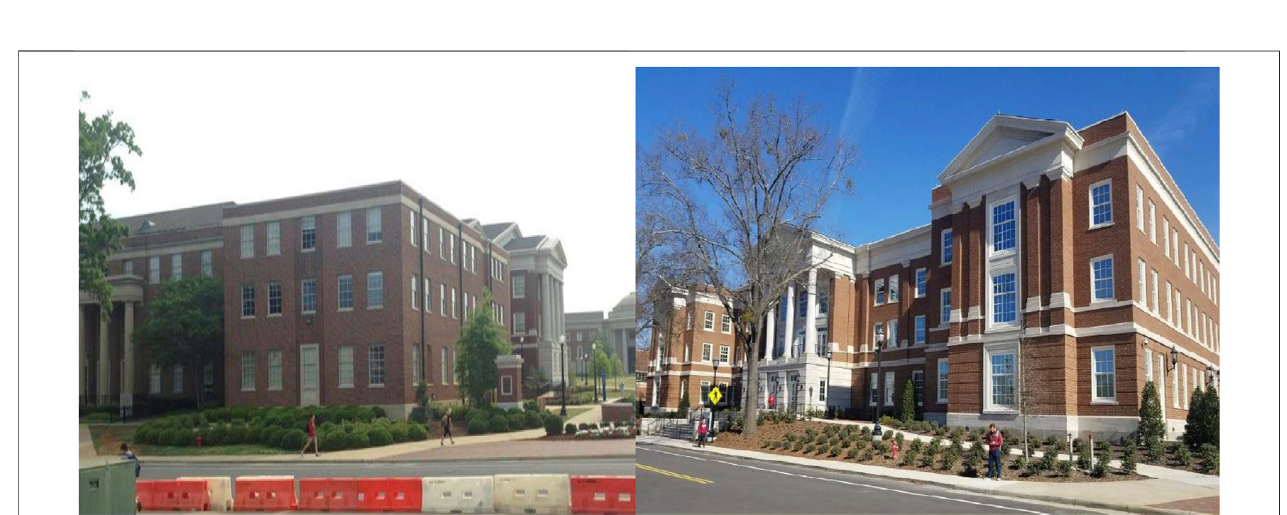
FIGURE 2 | H.M. Comer Hall prior to renovation (on the left ) vs. H.M. Comer Hall after renovation (on the right ).